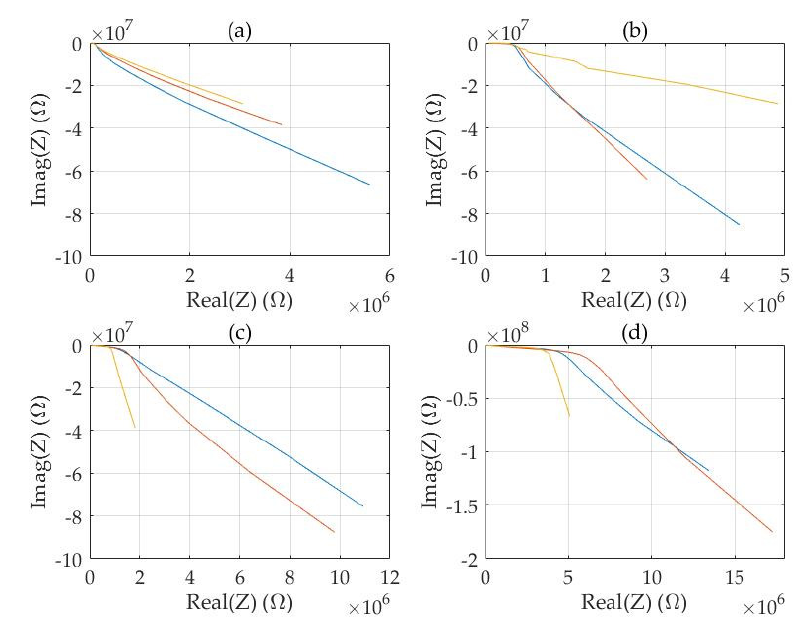
Figure 5. Examples of electrical complex spectra of fresh pine chips: ( a ) pine sapwood 100%, ( b ) pine sapwood 75%, heartwood 25%, ( c ) pine sapwood 25%, heartwood 75% ( d ) pine heartwood 100%. Frequency range 120 Hz–1 MHz. Measurements in x- (red), y- (blue) and z-directions (yellow, top to bottom).